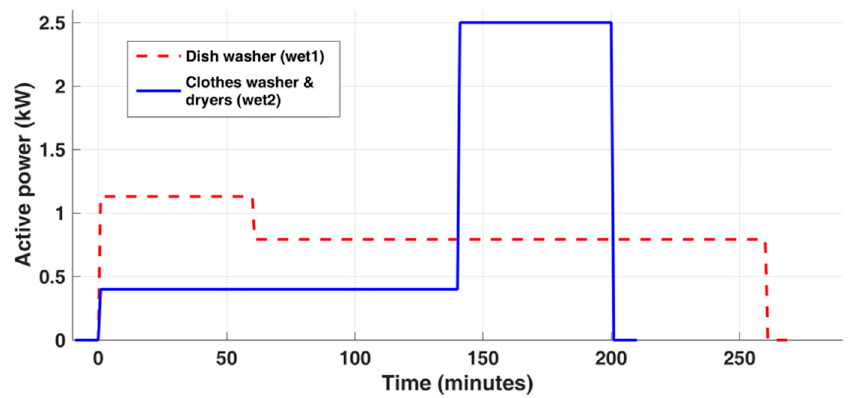
Figure 4. The average consumption profile of elastic appliances.